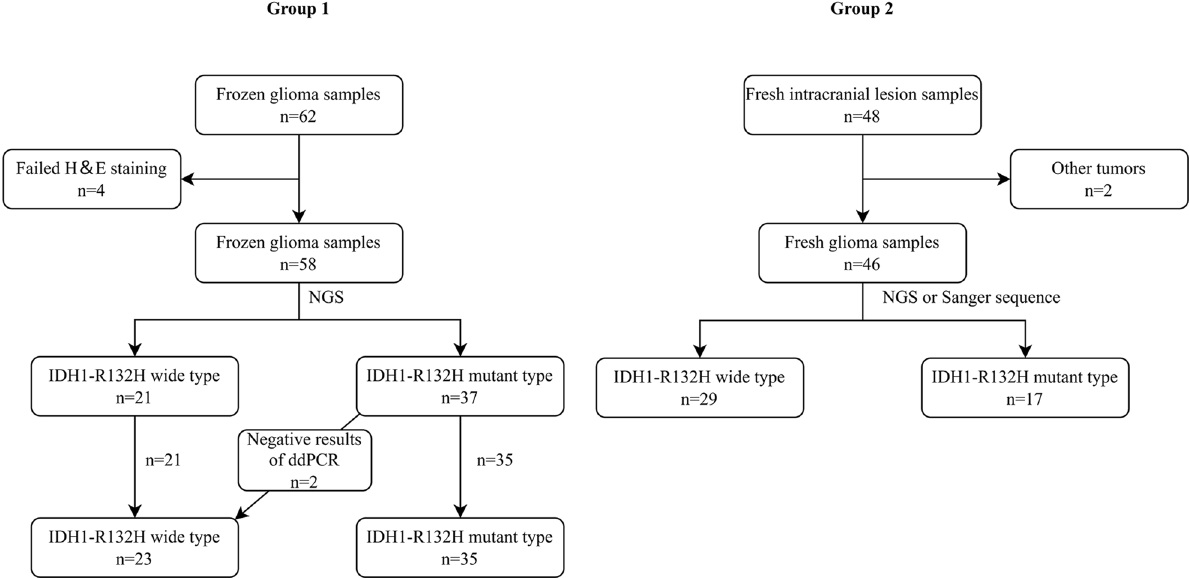
Figure 2. Distribution chart of IDH1-R132H in Group 1 and Group 2. A total of 110 clinical samples were selected; Group 1: 62 previous frozen glioma samples; Group 2: 48 recent fresh intracranial tumor samples.